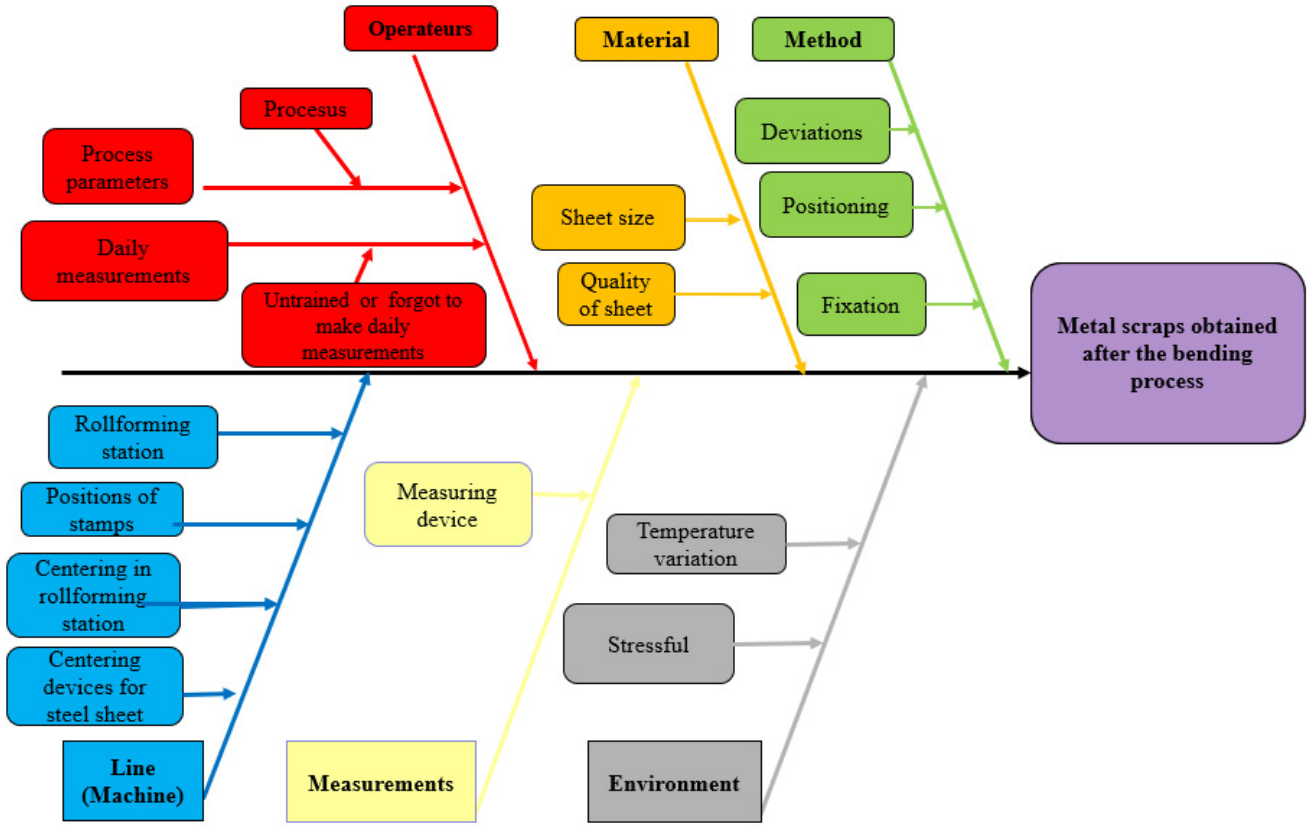
Figure 4. Ishikawa Figure 4. Ishikawa diagram.